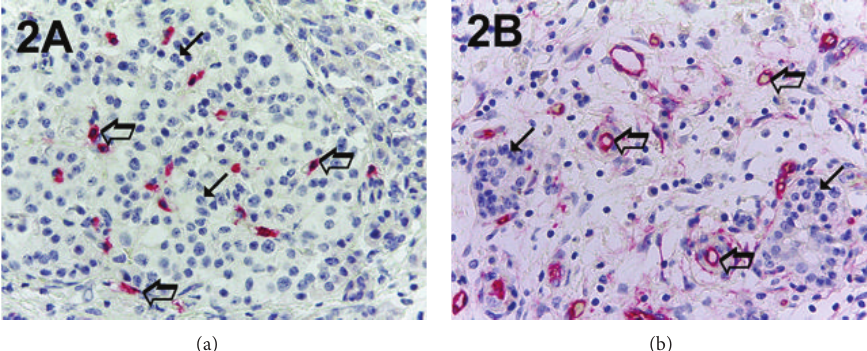
Figure 2: In (a) pancreatic ductal adenocarcinoma sample stained with the anti-tryptase antibody. Many scattered red immunostained MCs. Big arrows indicate single red MC and small arrows indicate the bleu nucleus of cancer cells. In (b) a highly vascularized pancreatic ductal adenocarcinoma sample stained with the anti-CD-31 antibody. Big arrows indicate single red microvessels with a lumen and small arrows indicate the bleu nucleus of cancer cells. Magnification: (a-b), × 400.